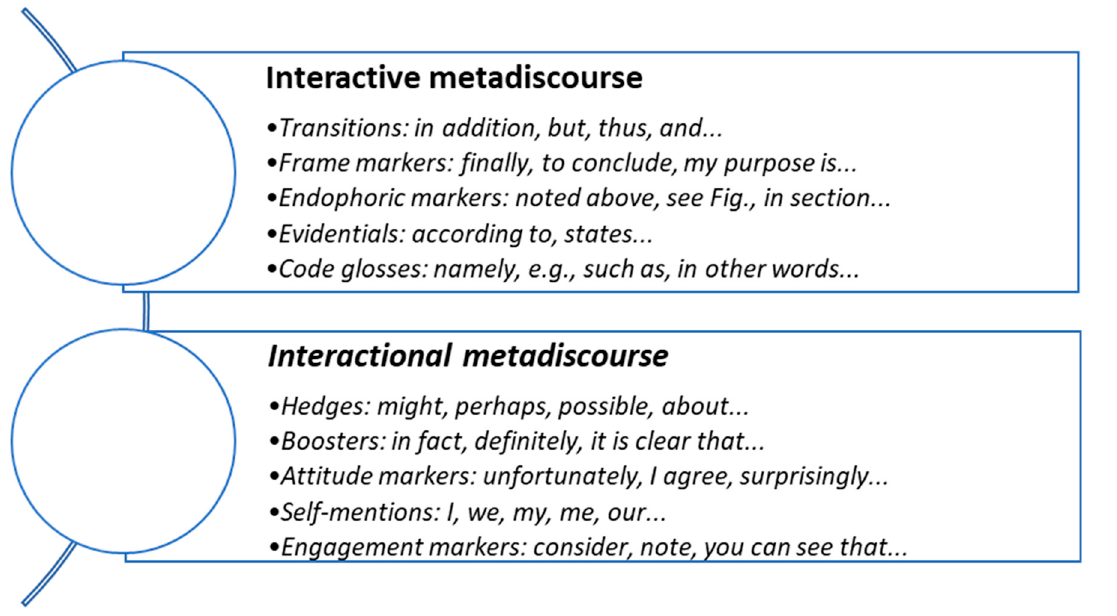
Figure 3. Categories of metadiscourse markers according to Hyland [5].